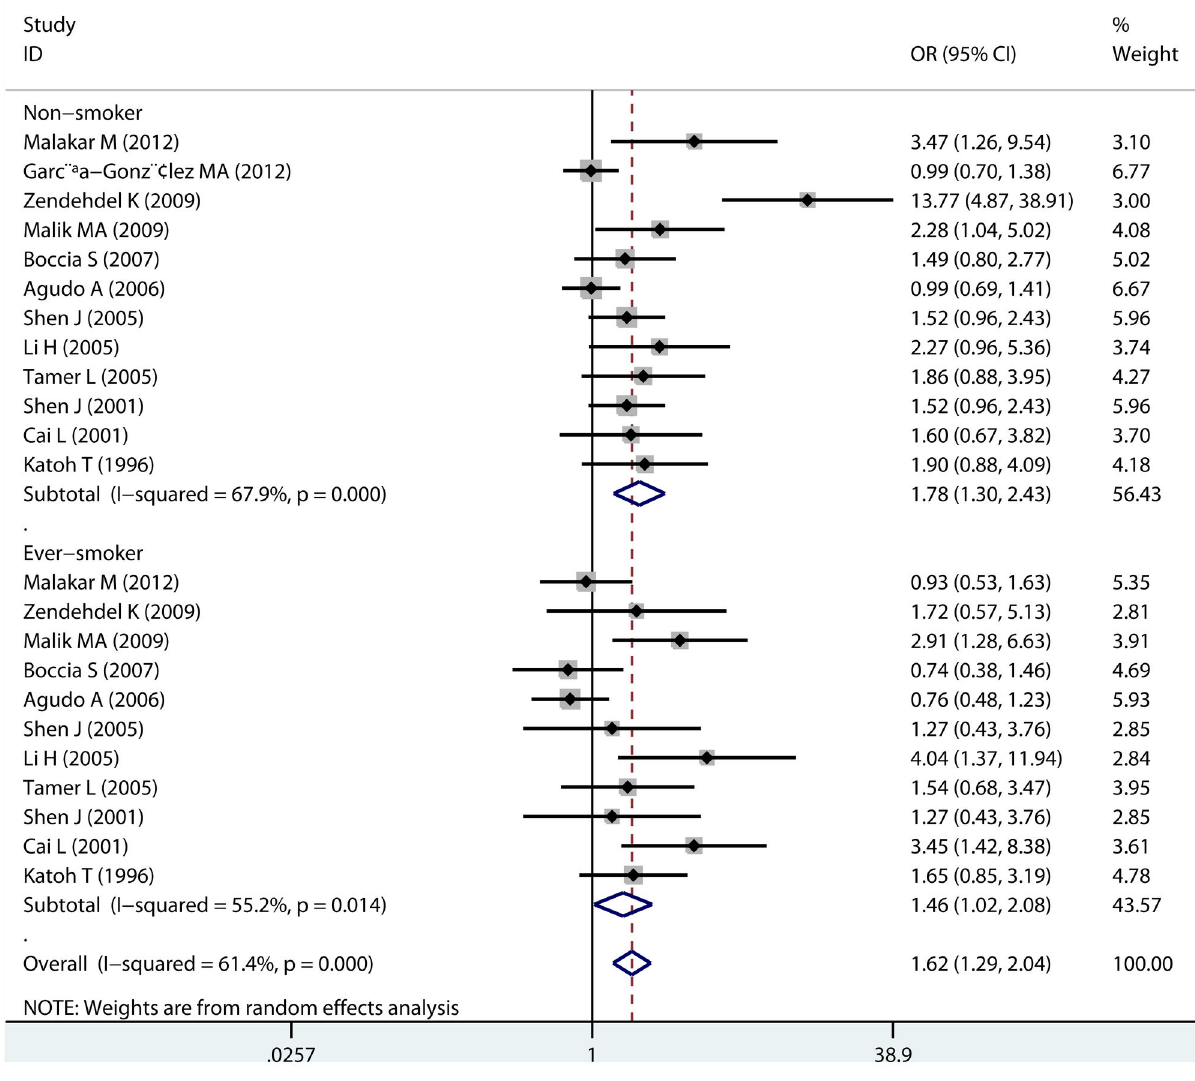
Figure S1. Sub-group analysis of